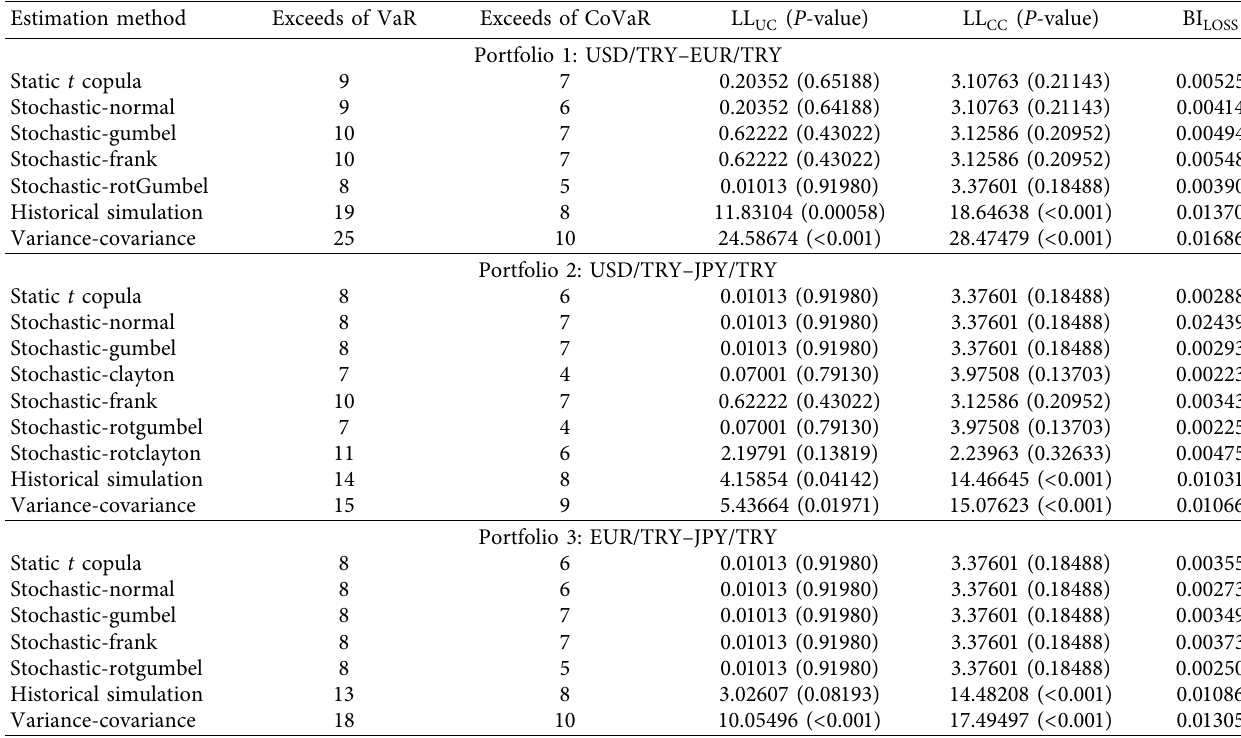
Table 5: Backtesting of VaR forecasts at 99% confidence